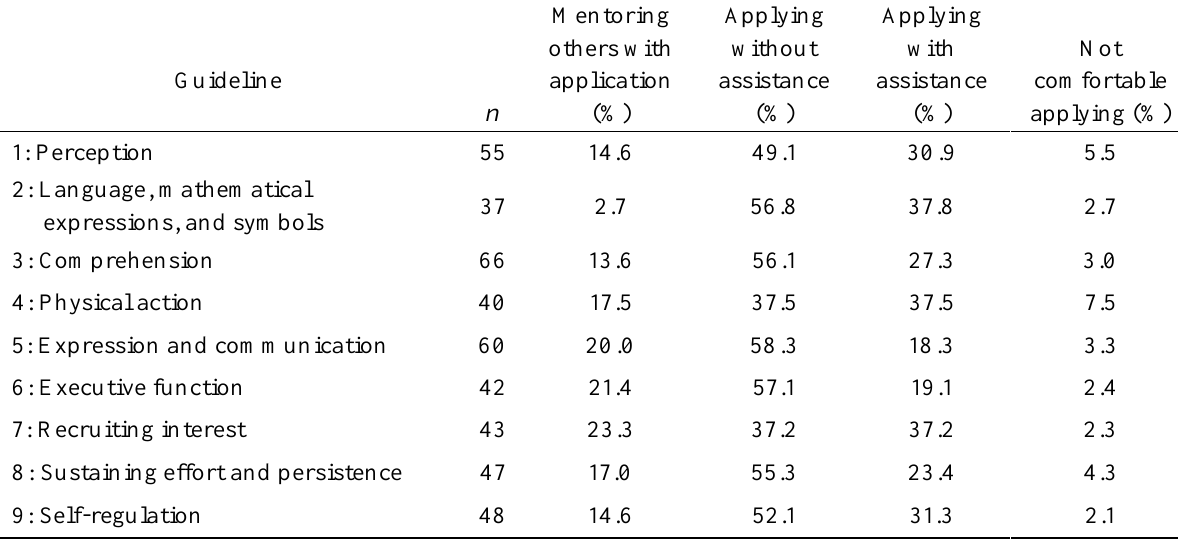
Respondents’ Self-Reported Level of Comfort in Applying the UDL Guidelines They Implement